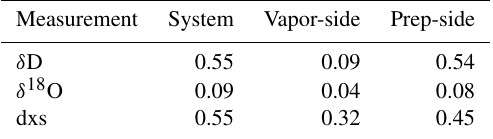
Table 6. The isotopic measurement precision (1 σ ) of varying parts of the CRDS-CFA system (‰). The difference in quadrature of the full-system precision derived from GTI (system) and the precision derived from IHW (vapor-side) gives an estimate of the noise added on the preparation side of the system (prep-side). The prep-side val- ues include noise added to the isotopic signal upstream of the Valco valve, while the vapor-side values include noise added to the iso- topic signal downstream of the Valco valve. Measurement System Vapor-side Prep-side